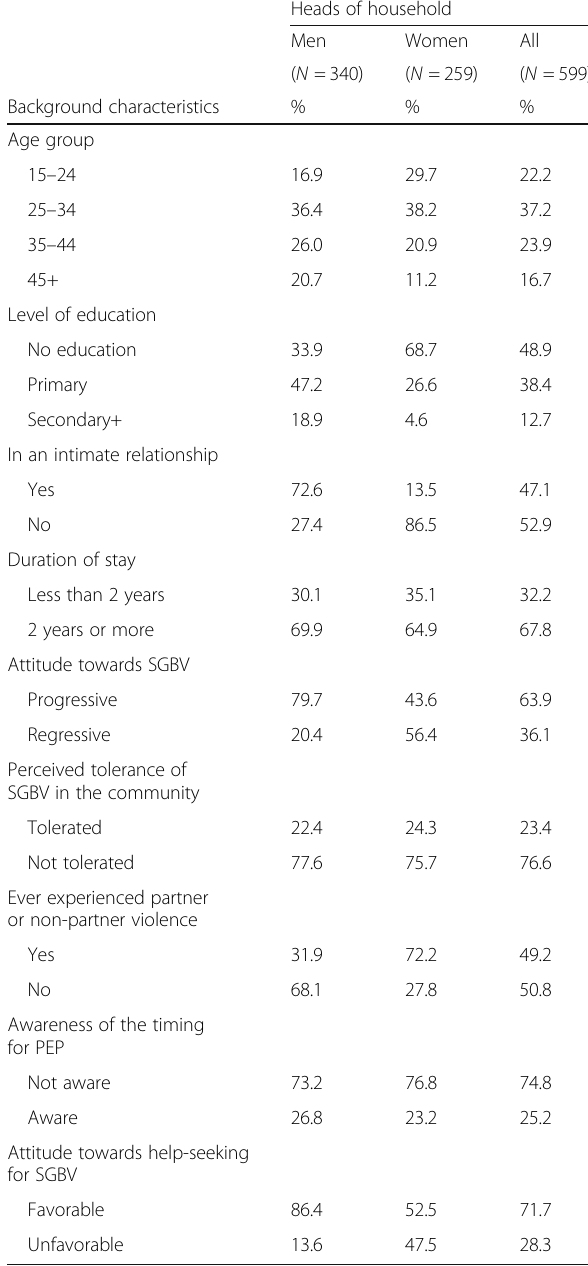
Table 2 Distribution of study participants by background